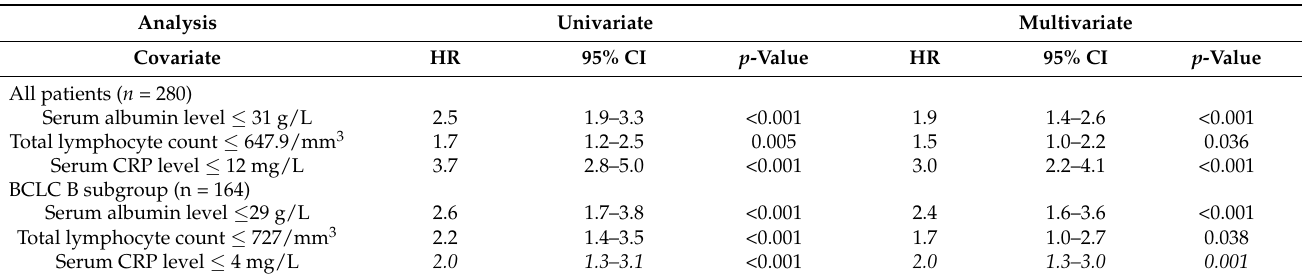
Table 4. Univariate and multivariate Cox proportional hazard regression model results for evaluating the individual CALLY parameters.